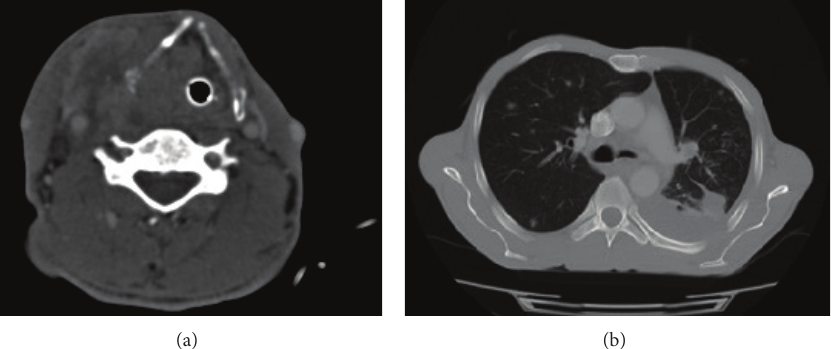
Figure 2: (a) CT scan with contrast enhancement showing a tumoral mass of the right pyriform sinus extending through the extralaryngeal region with thyroid cartilage destruction and prevertebral area involvement. (b) CT scan demonstrating multiple metastases in both